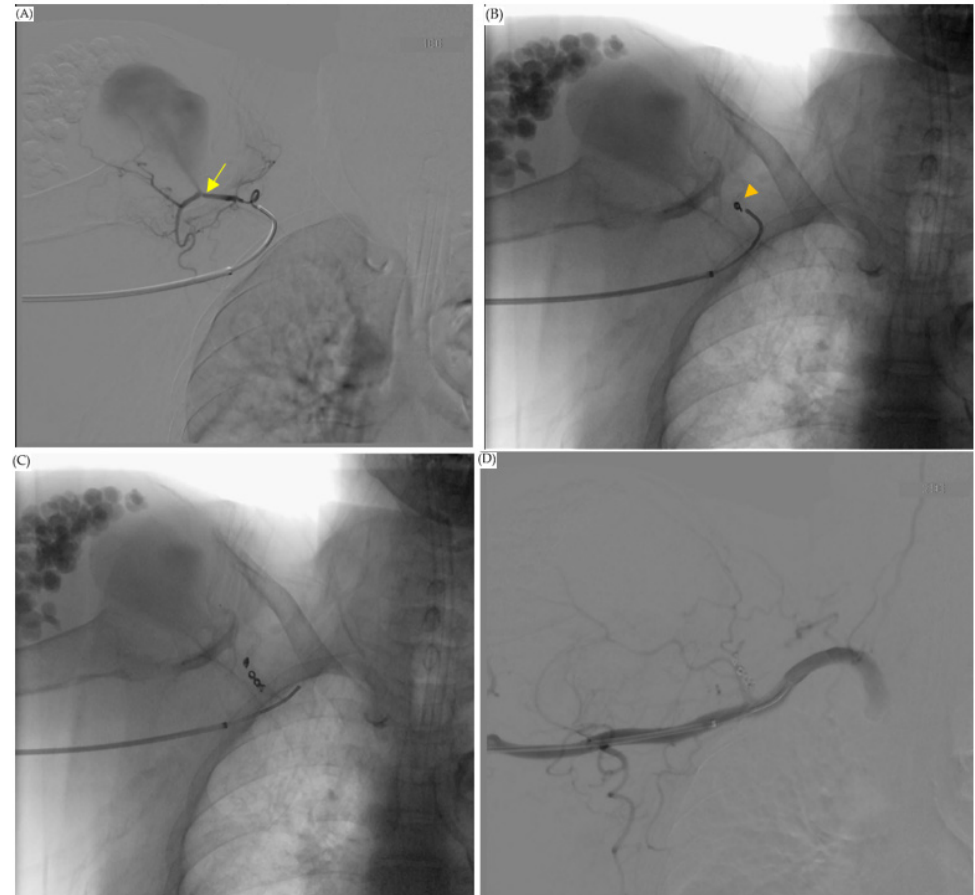
Figure 4. Operation: embolization of the thoracoacromial artery, acromial branch. ( A ) Guidewire with JB1 catheter attached to the acromial branch. Contrast medium injected from JB1 catheter showed we entered our target. The aneurysm stump was also detected (arrow). ( B ) We used Tornado coils (arrowhead) to coil the feeding artery. ( C ) Three Tornado coils were inserted in the thoracoacromial artery, acromial branch. ( D ) At the end of the operation, angiogram showed total embolization of the feeding artery. There was no contrast pooling into the pseudoaneurysm.